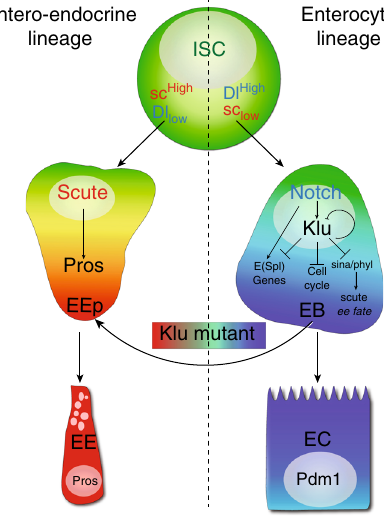
Fig. 8 Model for Klu function in ISC lineage differentiation. Our data suggest that Klu expression is activated by Delta-Notch signaling in the EB, together with other members of the Hairy/Enhancer of Split family of Notch target genes. Klu accumulation in EBs results in a subsequent repression of these target genes, including the repression of its own